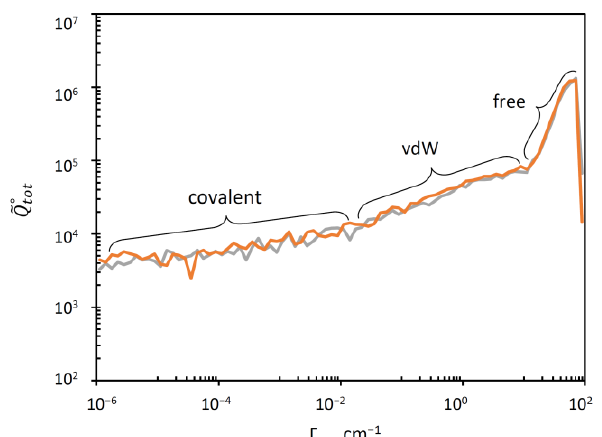
Figure 3. Distribution of resonance widths in singly ( grey ) and doubly ( orange ) substituted ozone molecules. Three ranges with different trends can be identified.